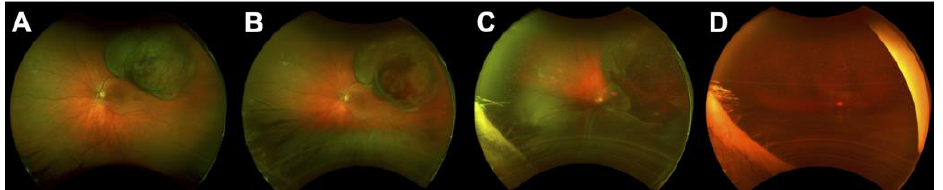
Figure 5. Intraocular hemorrhage following proton beam therapy for choroidal melanoma; ( A ) Ret- inography at baseline before irradiation. ( B ) Retinography at 6 months after irradiation showing intratumoral bleeding and toxic tumor syndrome (inferior exudative retinal detachment). The pa- tient refused any medical or surgical intervention. ( C ) Retinography at 9 months after irradiation showing subretinal bleeding and exudative retinal detachment. ( D ) Retinography at 12 months after irradiation showing total intravitreal